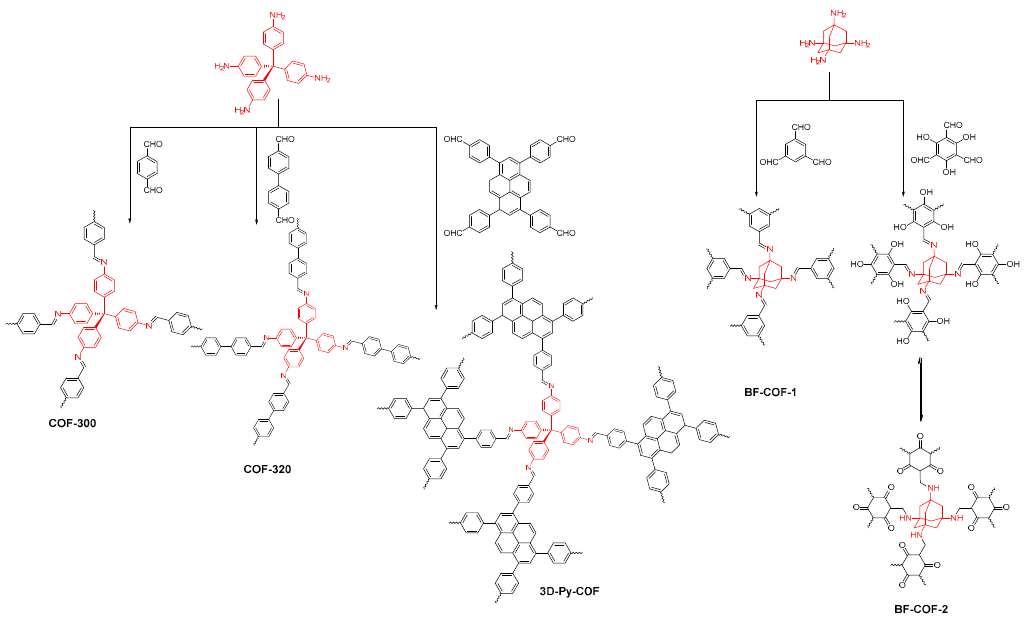
Figure 10. Construction of imine-linked COFs by co-condensation of tetratopic anilines (tetra-(4-anilyl)methane, and 1,3,5,7-tetraaminoadamantane) with various ditopic, tetraaldehydes and triangular aldehydes to form 3D networks.